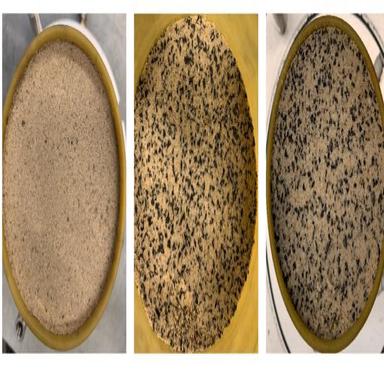
Sand and sand-tyre mixes (a) Sand (b) Sand with 10 % tyre rubber (c) Sand with 20 % tyre rubber (d) Sand with 30 % tyre rubber (e) tyre crumb.